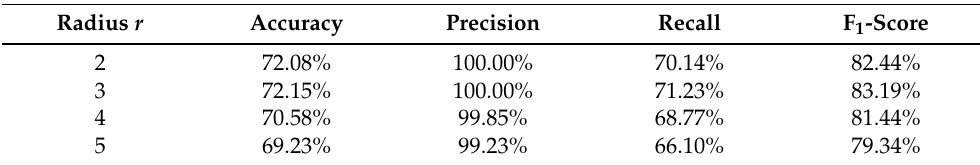
Table 2. Performance evaluation on the UMCD dataset for Radius r size. All rows are computed using a Patch size P = 80 × 100.